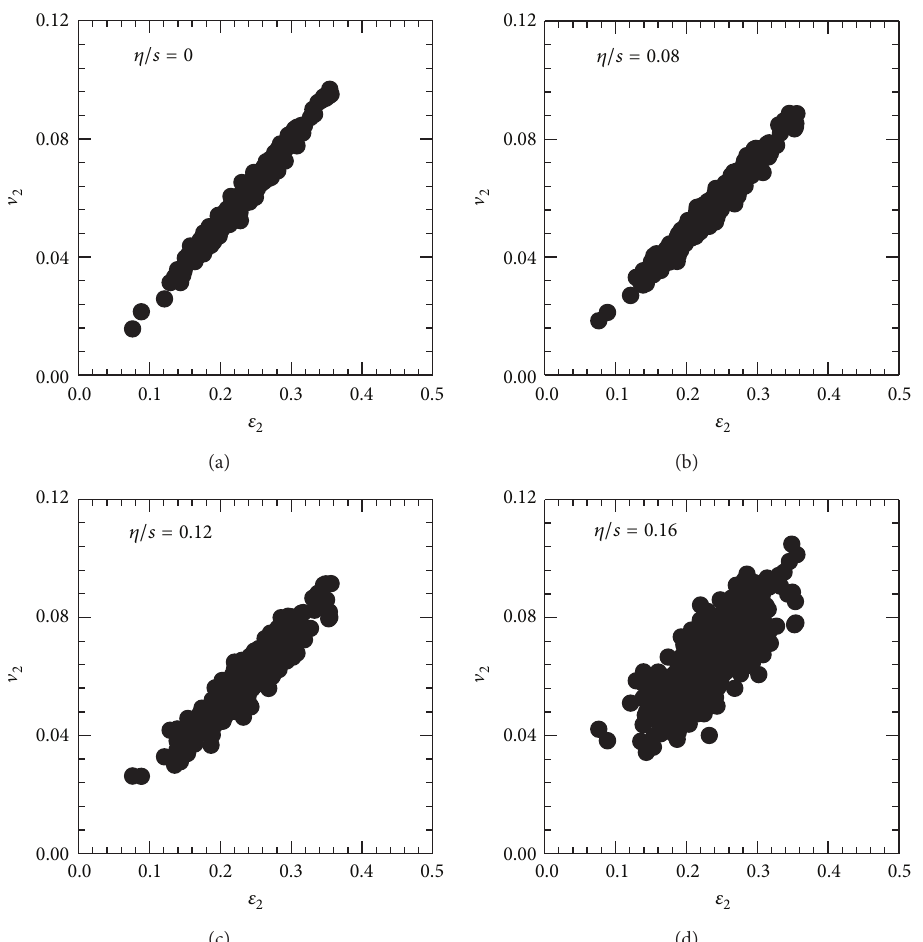
Figure 22: Correlation between elliptic flow ( V 2 ) and initial eccentricity (𝜖 2 ) is shown for four values of fluid viscosity to entropy ratio 𝜂/𝑠 = 0 , 0.08, 0.12, and 0.16. The figure is from